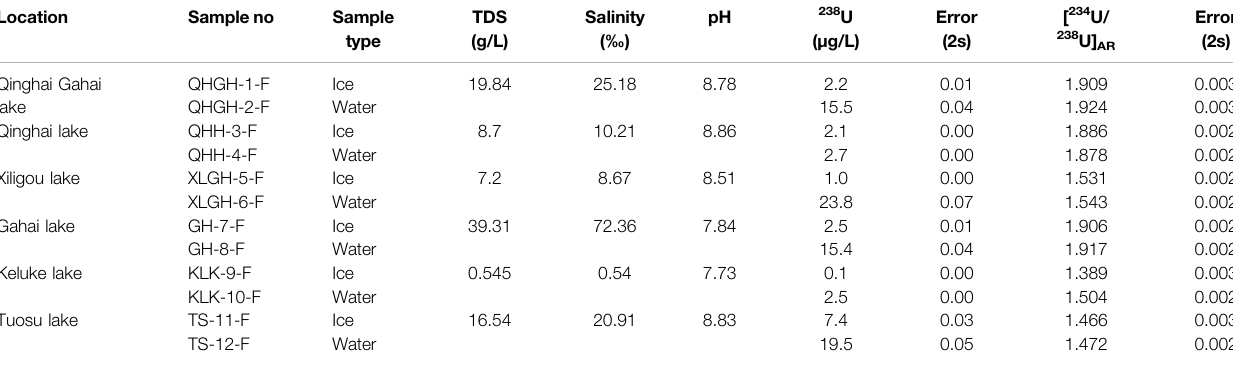
TABLE 4 | Geochemistry data for ice and the overlying water samples from the six lakes.